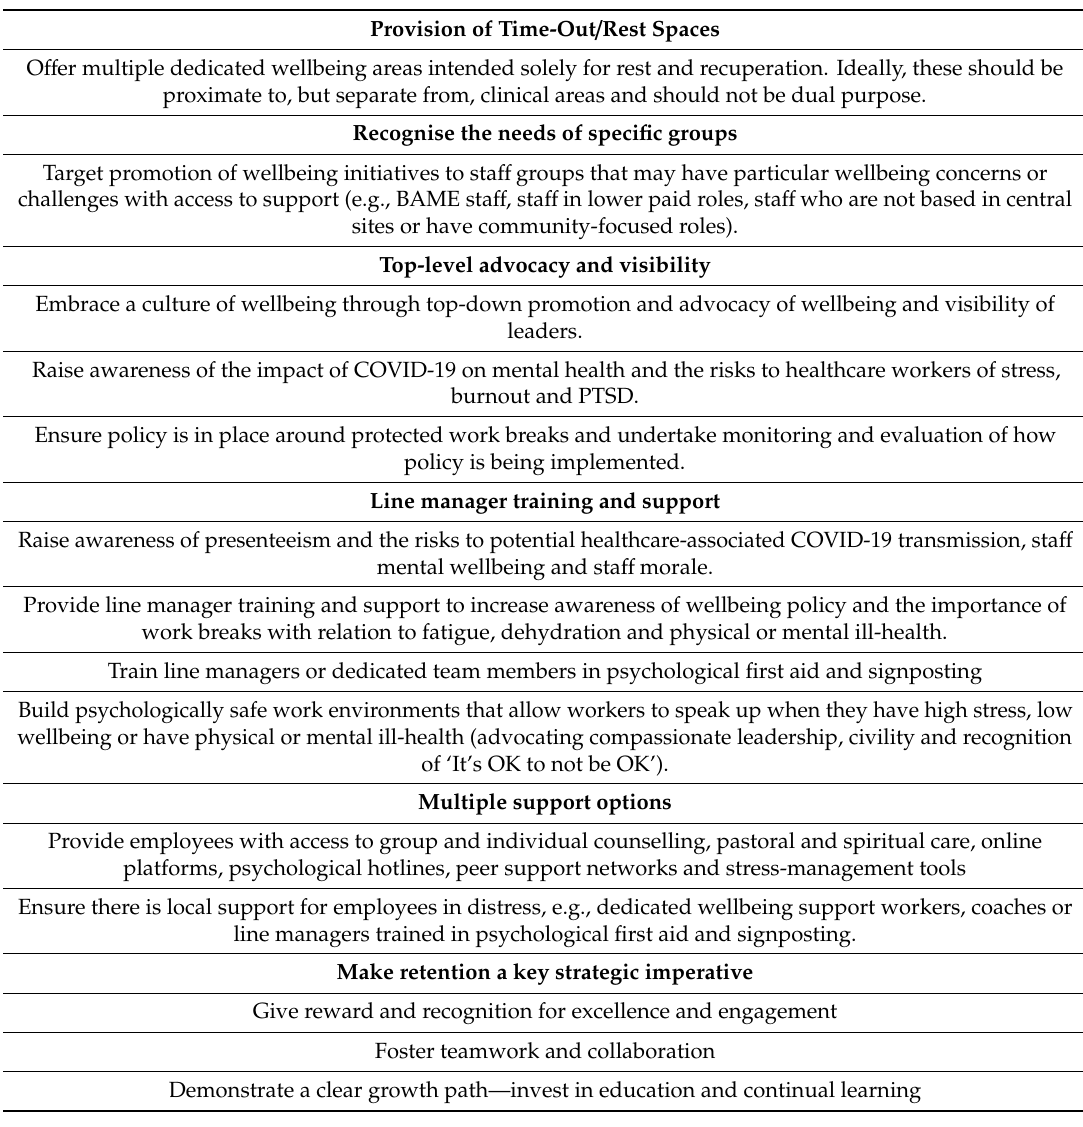
Table 6. Recommended actions for healthcare